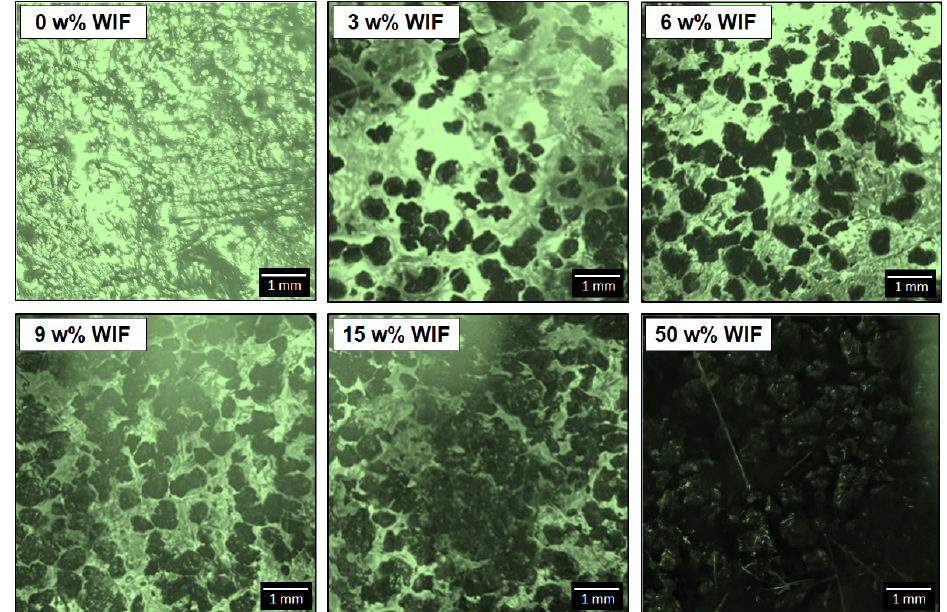
Figure 6. The microstructure of the GFRE composites with and without WIF using optical light mi- croscopy.